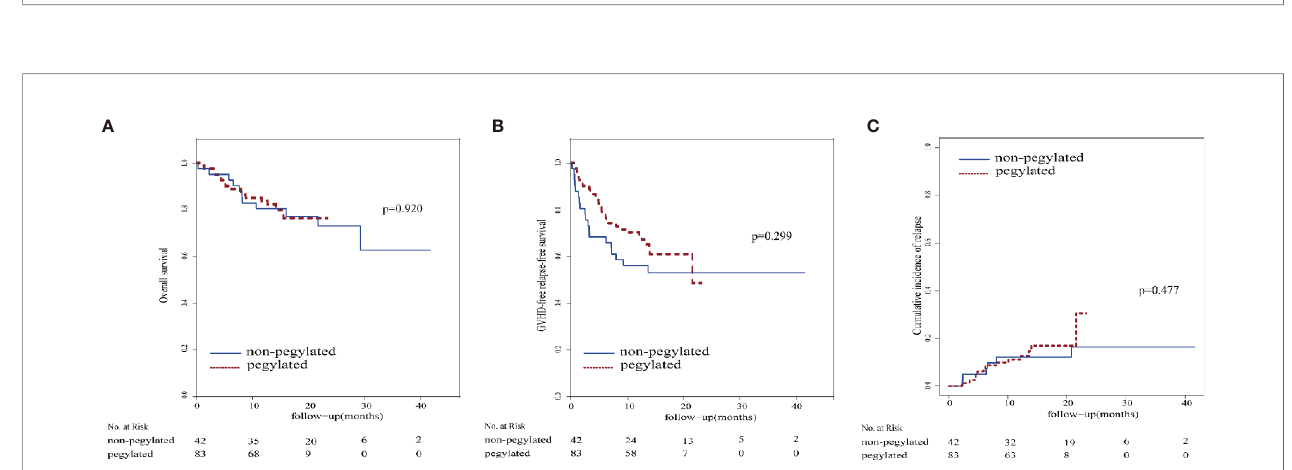
FIGURE 2 | Graft-versus-host disease cumulative incidence. (A) aGVHD cumulative incidence, (B) II-IV aGVHD cumulative incidence, (C) III-IV aGVHD cumulative incidence, (D) cGVHD cumulative incidence, (E) moderate-severe cGVHD cumulative incidence.